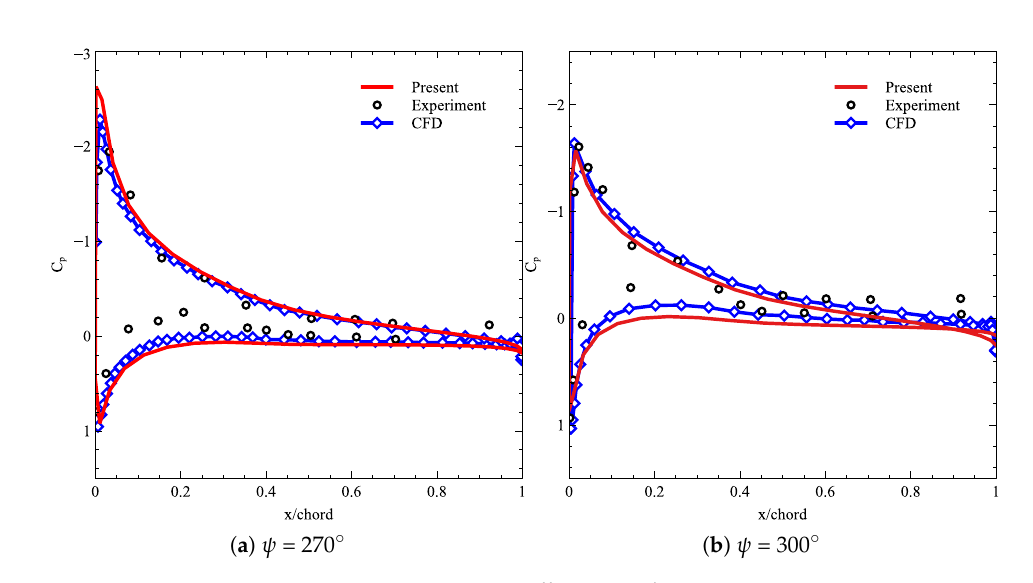
Figure 11. Pressure coefficient at r/R = 0.91.